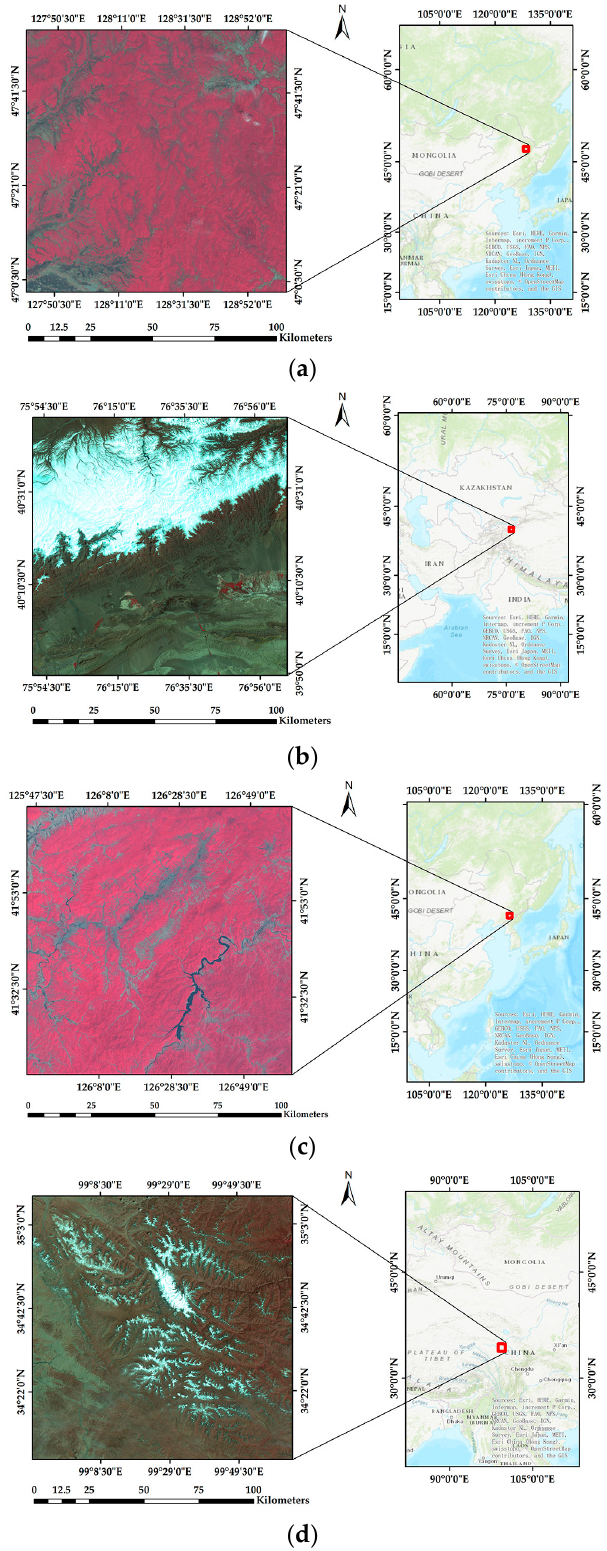
Figure 10. Parts of experimental data: ( a – d ) are remote sensing images of Landsat7.